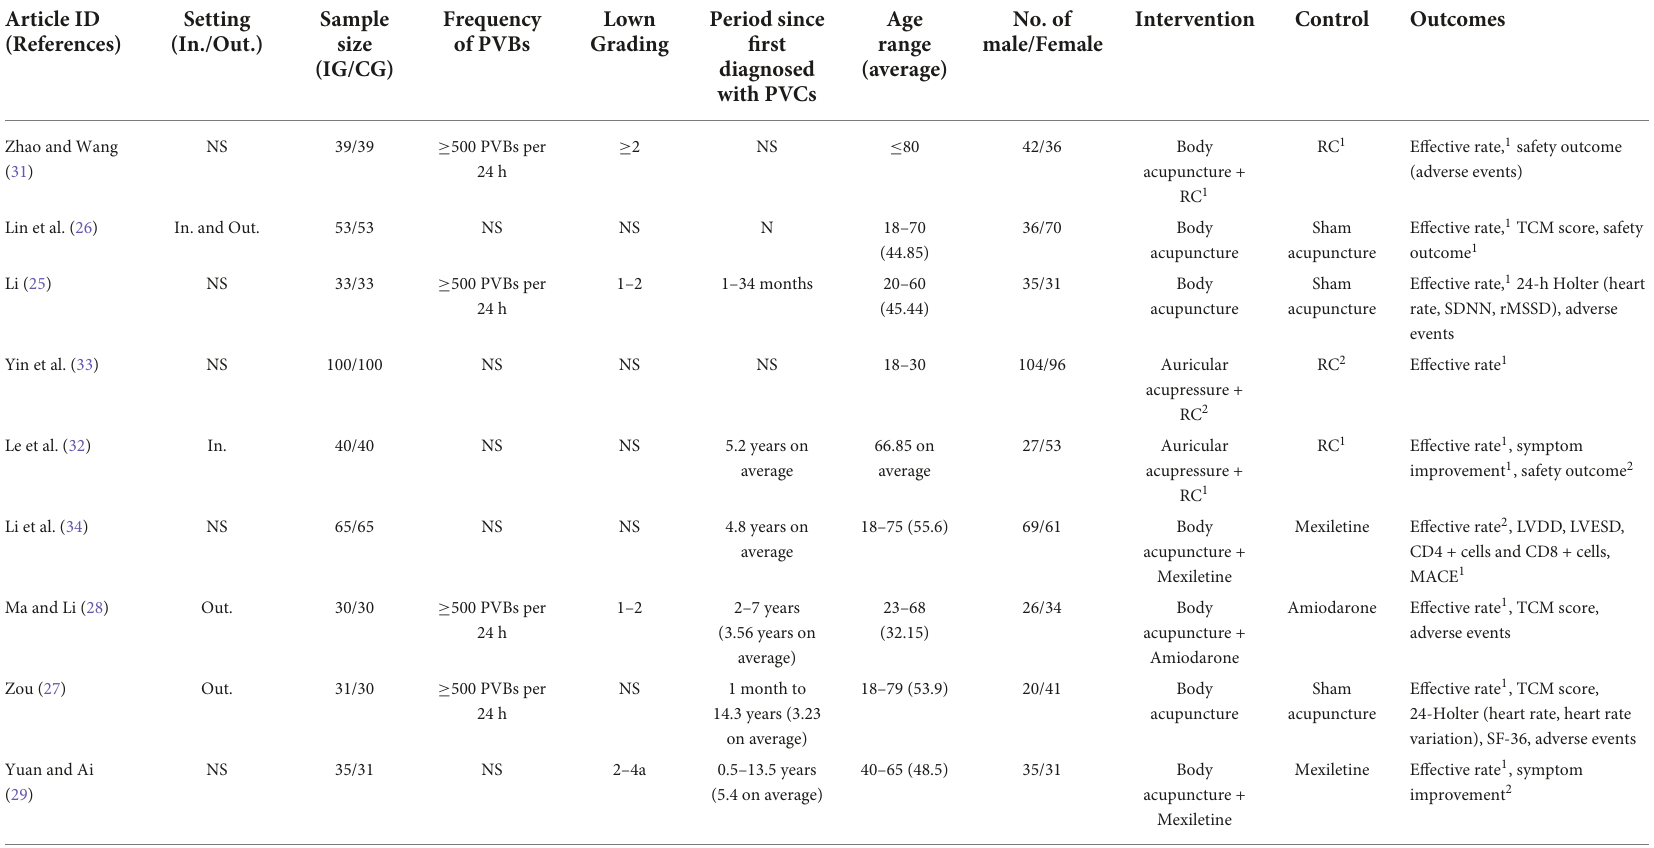
TABLE 1 Baseline characteristics of included